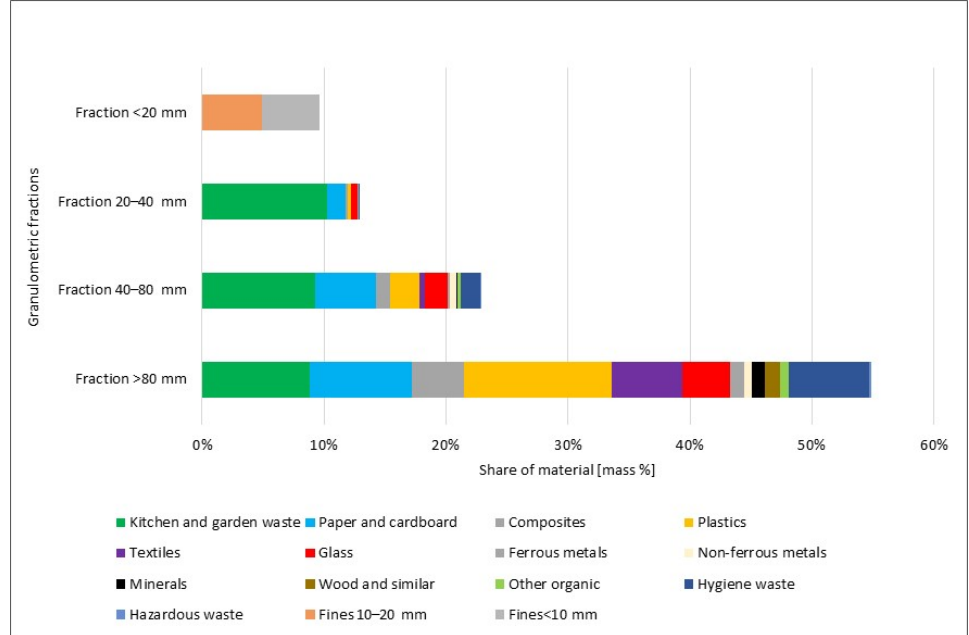
Figure 8. Residual waste composition by major fractions in Wroc ł aw.